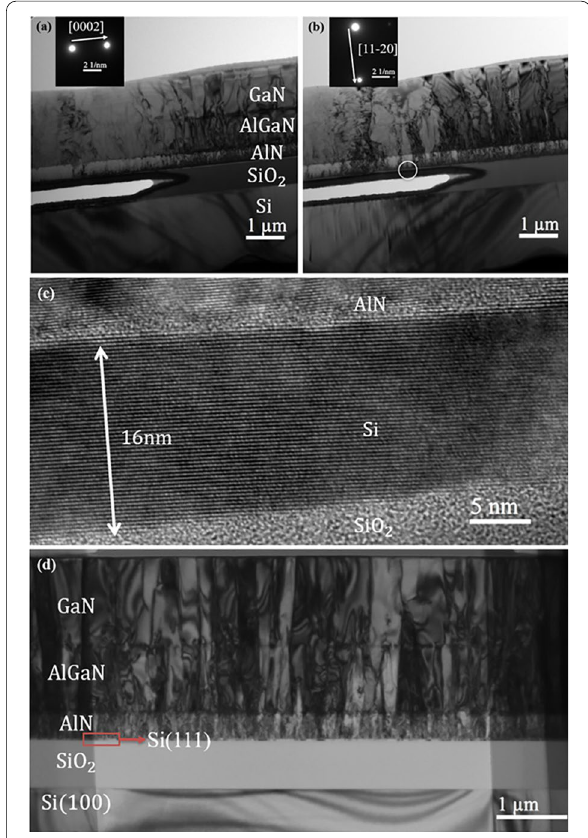
Fig. 5 Bright-field cross-sectional TEM images of a suspended ultrathin sample viewed along the [1–100] zone axis with the reflections a g [0002] and b g [11–20]; the left half of the figures = = are the fully suspended zones, and right half is non-suspended area. c High-resolution TEM image around the circle zone in b , indicating the 16 nm thin Si layer between AlN and SiO 2 layer. d TEM image at the plain SOI regions further away from the right side of the